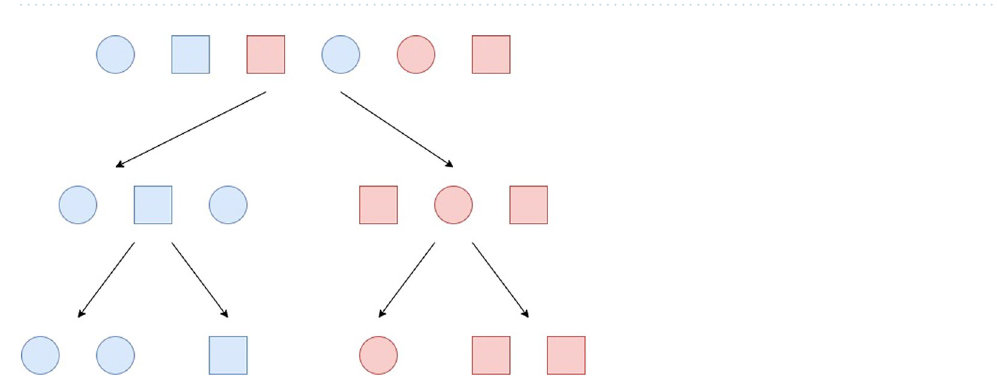
Figure 21. This decision tree example illustrates the classification of samples by two different features, colour and then